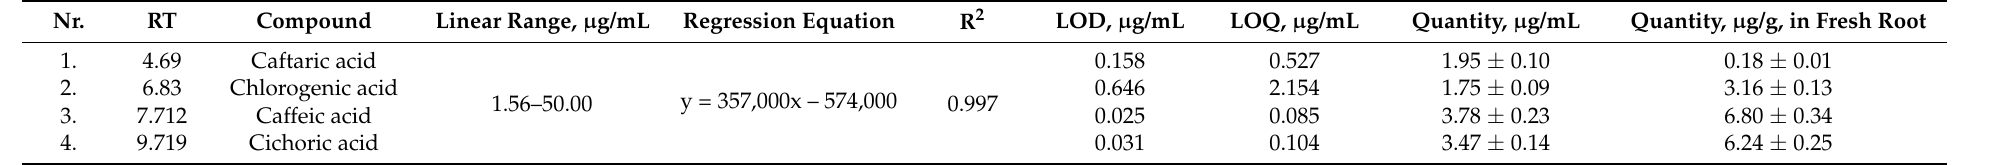
Table 1. Results of Echinacea purpurea (L.) Moench fresh roots’ tincture (1: 5) phenolic acid’s quantity (as equivalent to caffeic acid) determination.